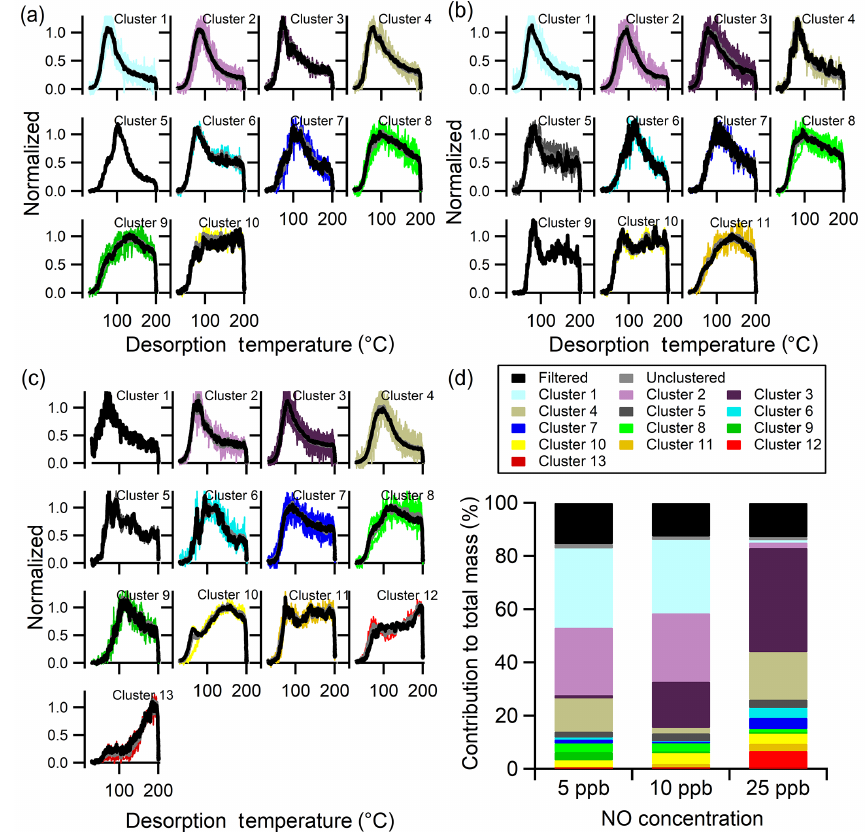
Figure 10. Multiple-clustering results for α -pinene + OH SOA as a function of NO concentration. Clustering results are separately shown for the (a) 5ppb NO, (b) 10ppb NO, and (c) 25ppb NO experiments. Each panel includes unweighted average thermograms (gray lines), mass-weighted average thermograms (black lines), and individual cluster members (colored lines). (d) The contribution of each cluster to the total mass for each experiment. The mass contribution of filtered-out ions (black bar) and unclustered ions (gray bar) is also